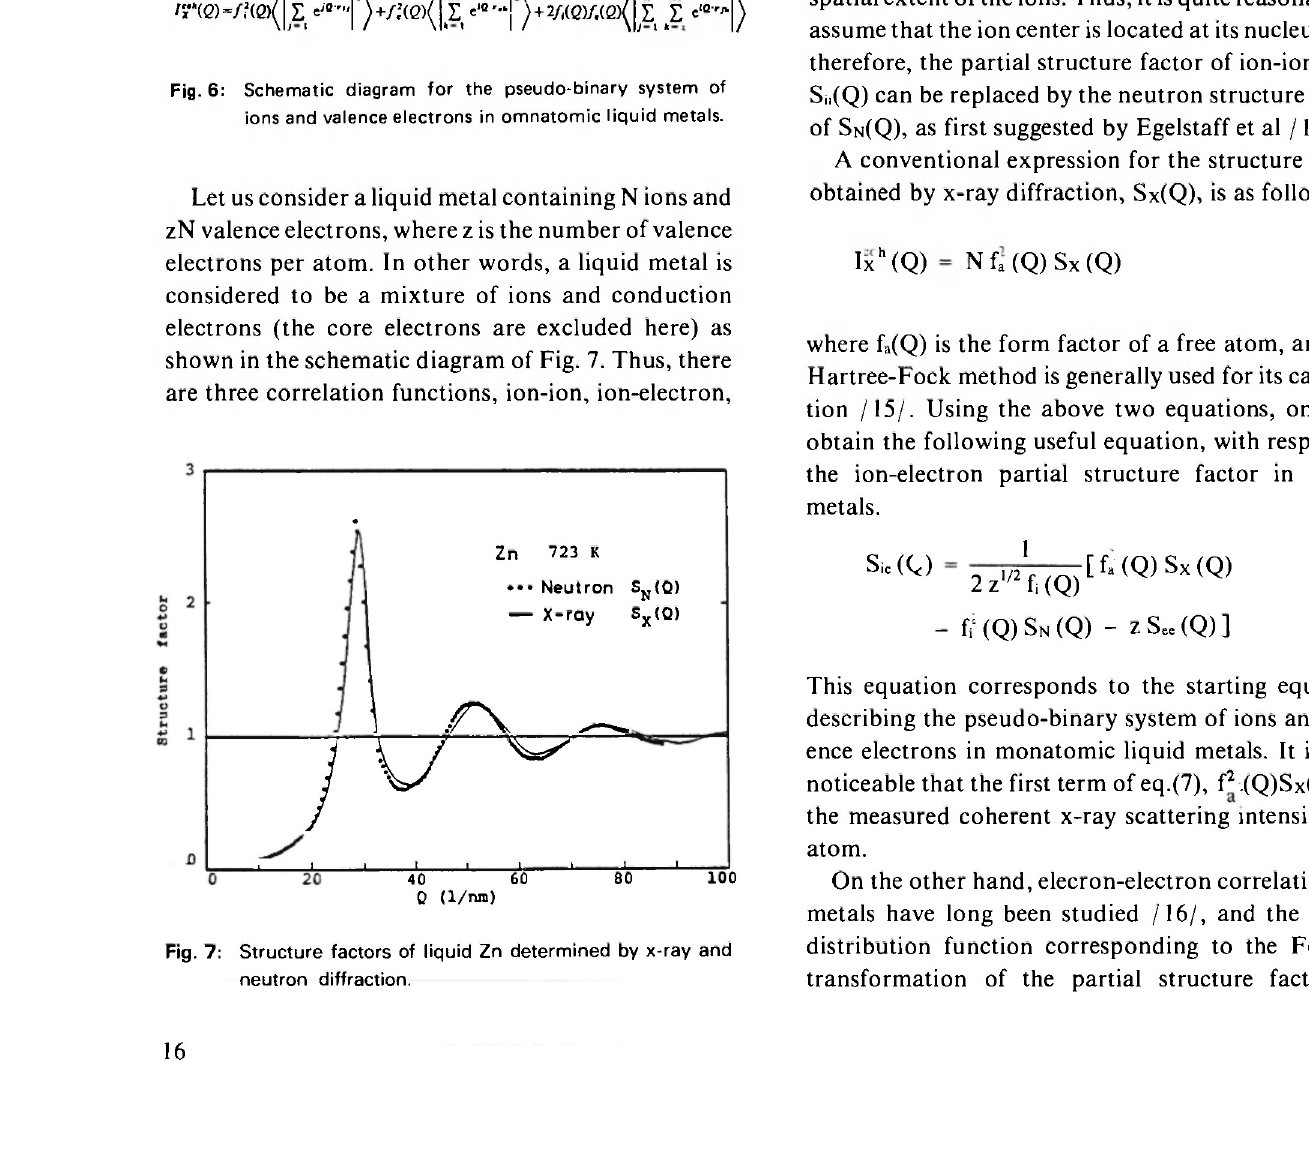
Fig. 6: Schematic diagram for the pseudo-binary system of ions and valence electrons in omnatomic liquid metals.